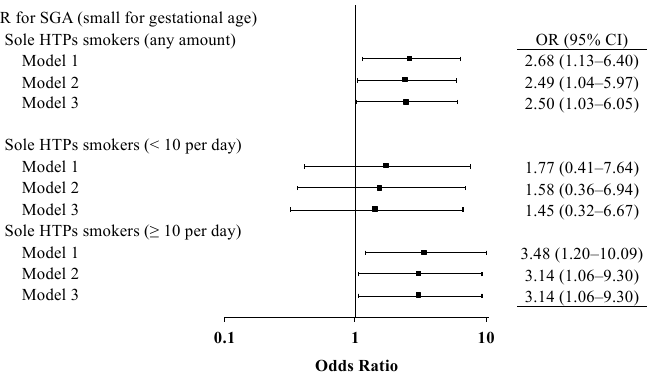
Figure 2. Odds ratios of current sole HTP smokers (any amount, <10 per day, and ≥ 10 per day) for SGA compared with never-smokers. CI, confidence interval; HTPs, heated tobacco products; OR, odds ratio; SGA, small for gestational age.